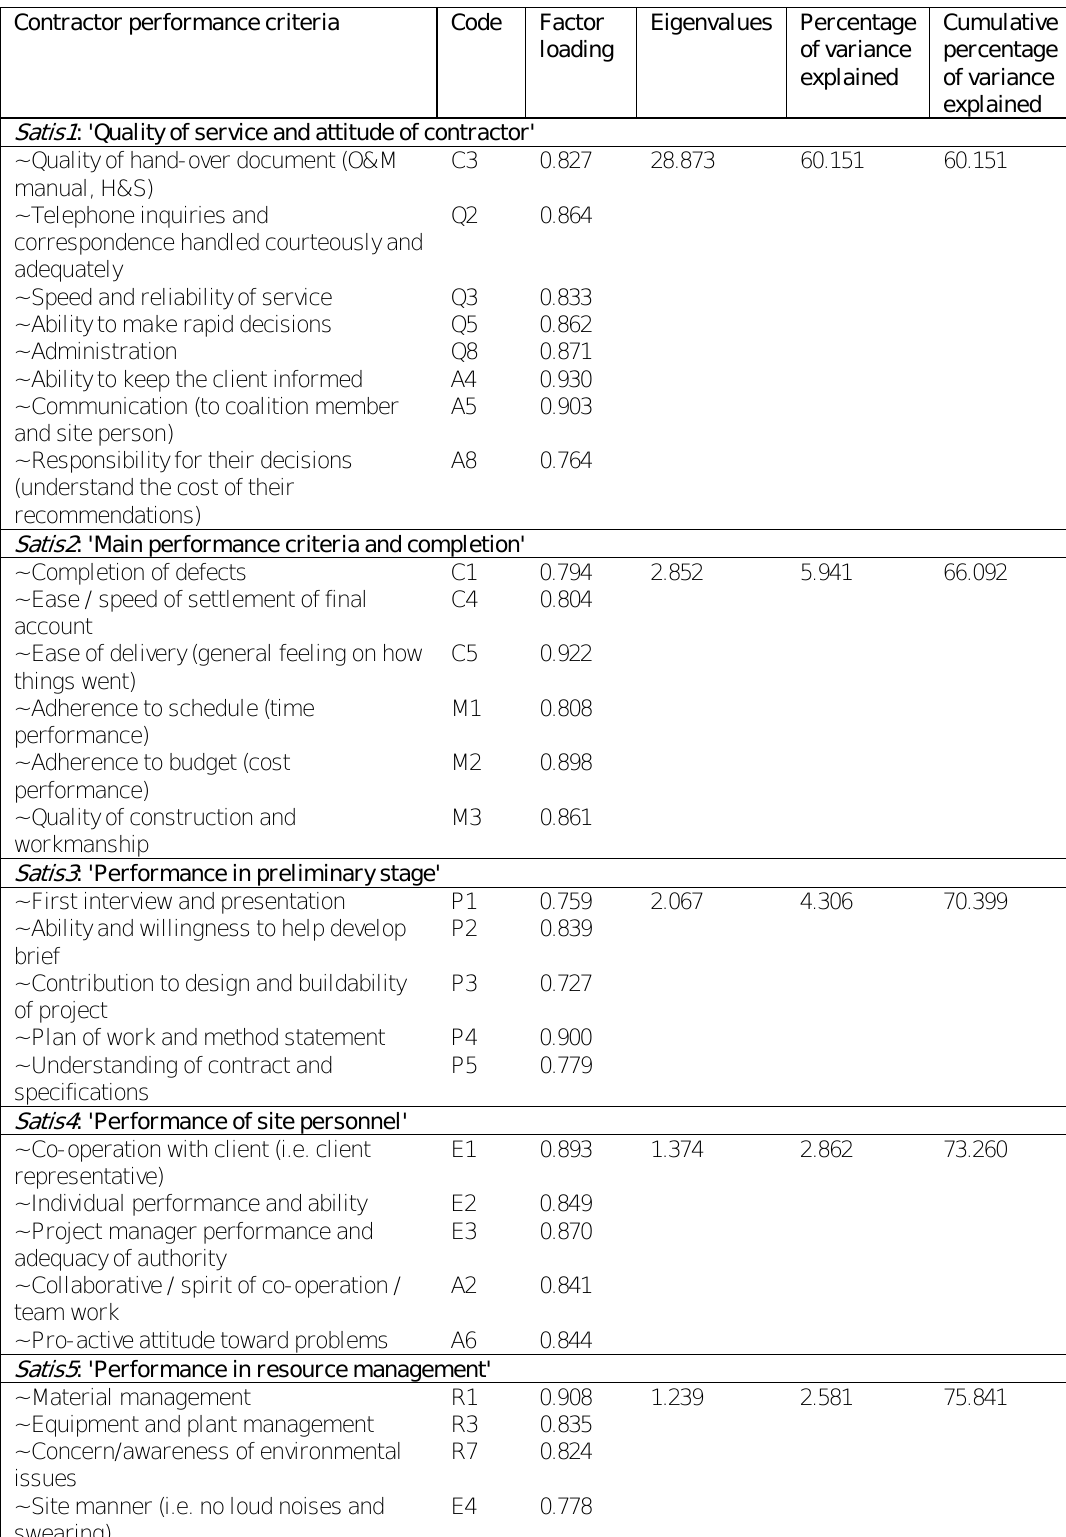
Table 3: Factor structure of contractor performance criteria based on clients' assessment Contractor performance